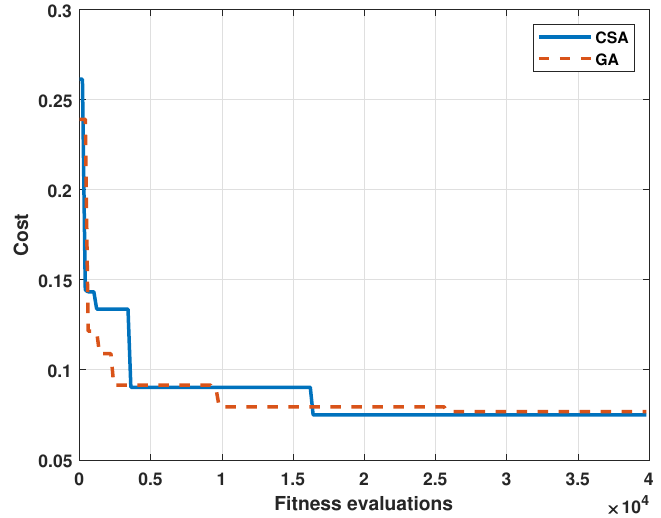
Figure 12. Function costs for both